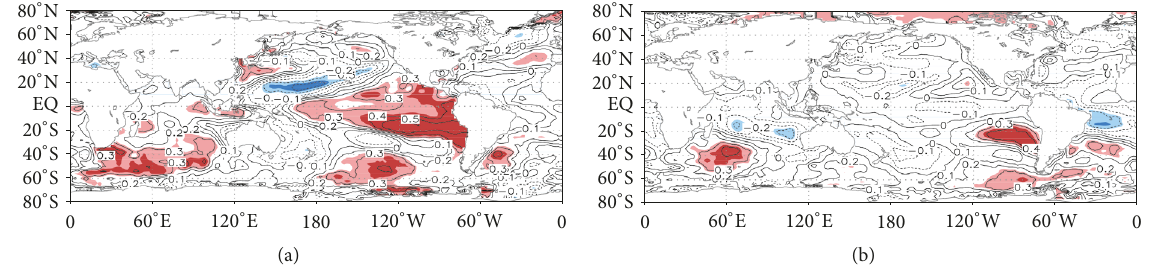
Figure 11: Correlation analyses of the IEAH (a) and IEMH (b) with the global SST anomalies from the preceding winter. Significant values exceeding the 90%, 95%, and 99% confidence levels ( 𝑡 -test) are